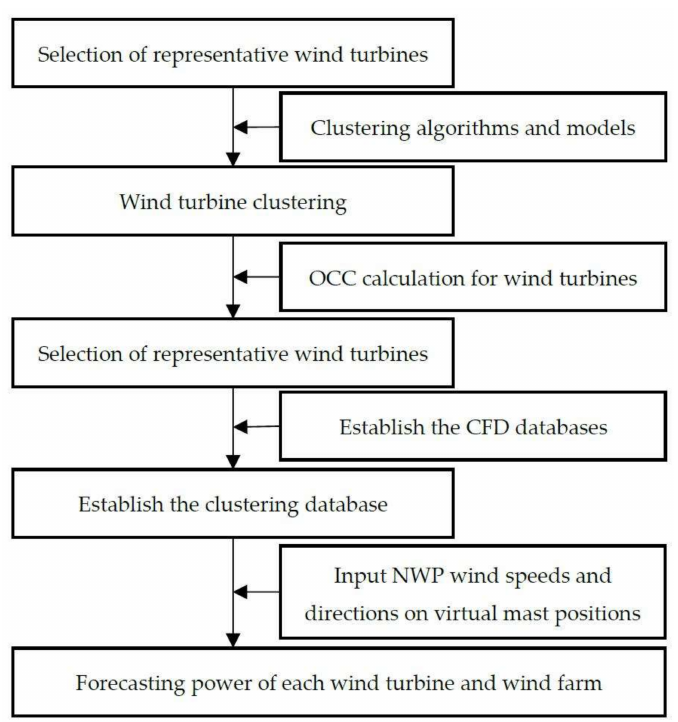
Figure 7. The modeling process of the WPF based on clustering